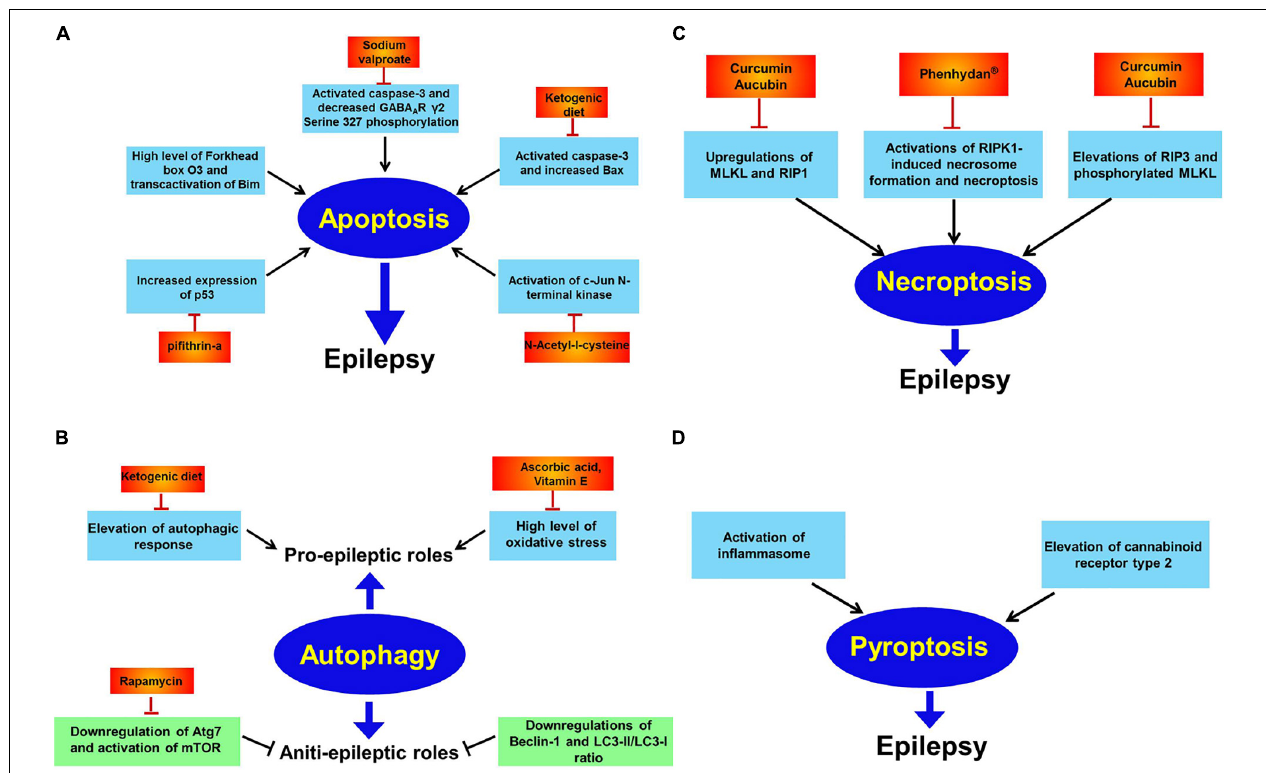
FIGURE 2 | Apoptosis, autophagy, necroptosis, and pyroptosis in epilepsy. Panel (A) indicates apoptosis in epilepsy. Extensive investigations has illustrated elevations of oxidative stress, Forkhead box O3, p53, and c-Jun N-terminal kinase while decreased GABA A R γ 2 Serine 327 phosphorylation are reported to trigger neuronal apoptosis and subsequently promote epileptic phenotype. And many drugs including sodium valproate, pifithrin-a, N -acetyl-l-cysteine and supplement with ketogenic diet all counteract epileptic seizures via inhibiting apoptosis; panel (B) shows autophagy in epilepsy. Autophagy has dual effects on epilepsy. That is pro-epileptic and anti-epileptic roles. On the one hand, induction of autophagic response by high level of oxidative stress has been found to cause epilepsy. Diverse therapeutic interventions including ascorbic acid, vitamin E and ketogenic diet exert curative potential against epilepsy. On the other hand, autophagic activation by rapamycin has therapeutic effect against epilepsy via inhibition of mTOR; panel (C) shows necroptosis in epilepsy. Activations of RIP1, RIP3, MLKL, and phosphorylated MLKL have been reported to induce necroptosis and contribute to epileptogenesis. However, curcumin, aucubin or phenhydan R (cid:13)